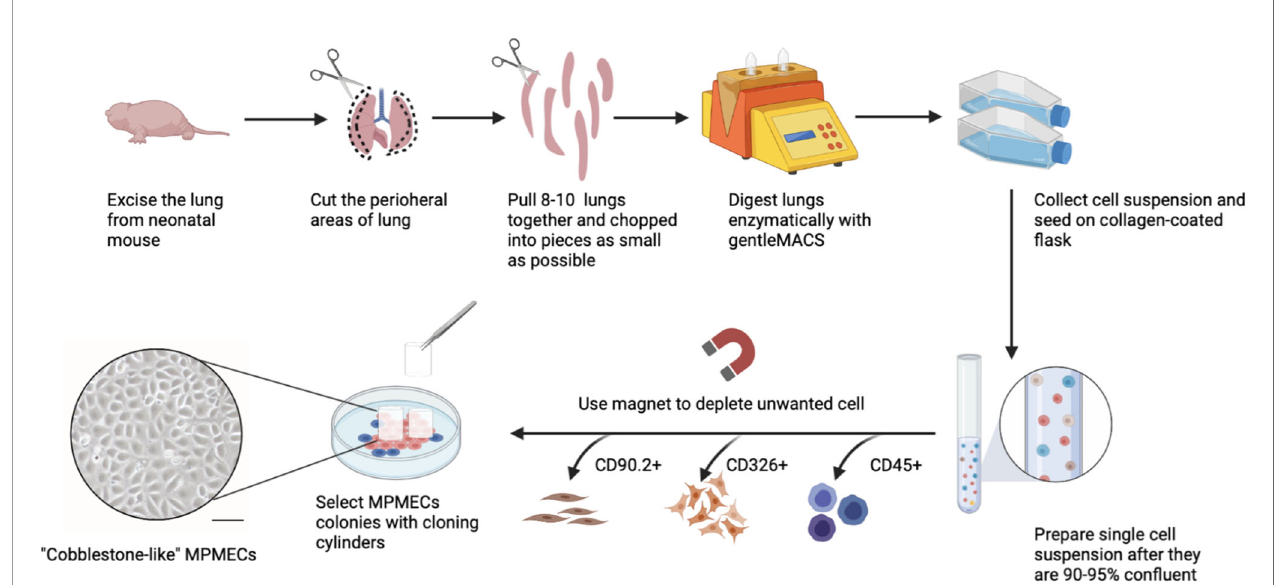
FIGURE 2 | Schematic representation of primary mouse pulmonary microvascular endothelial cell (pMPMEC) isolation. Peripheral rims of mice lungs are chopped into pieces and digested into a single-cell suspension. The whole lung cells are plated in type I collagen-coated T-75 fl asks. CD31 + predominant cells are chosen by depleting CD45 + , CD90.2 + , and CD326 + cells using magnetic beads. High-purity pMPMEC clones are carefully marked and isolated by using a cloning cylinder. pMPMECs are cultured in a speci fi cally designed medium and prepared for lentivirus transduction. Scale bar, 50 m m. This fi gure is created via Biorender (biorender.com).